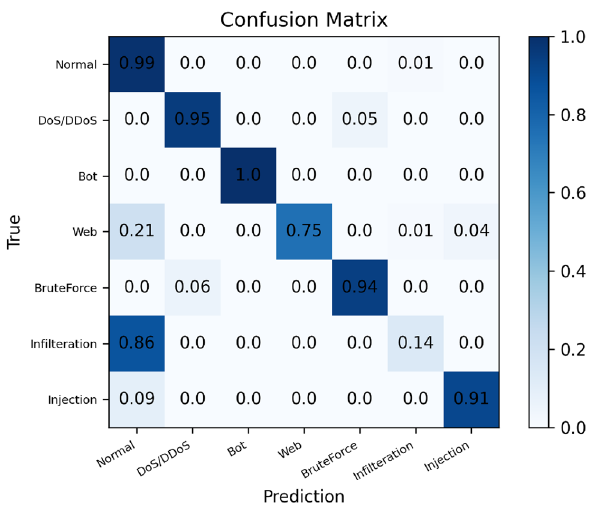
Figure 8. Multi-category confusion matrix (DT). The numbers in the confusion matrix indicate the proportion of samples that are classified from the original category represented by the horizontal axis to the category represented by the vertical axis.